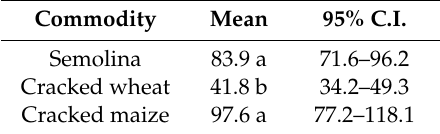
Table 2. Survival times in days (mean, 95% C.I.) of Tribolium castaneum fed on three commodities. Means followed by the same letter are not statistically di ff erent based on the 95% C.I. criterion.